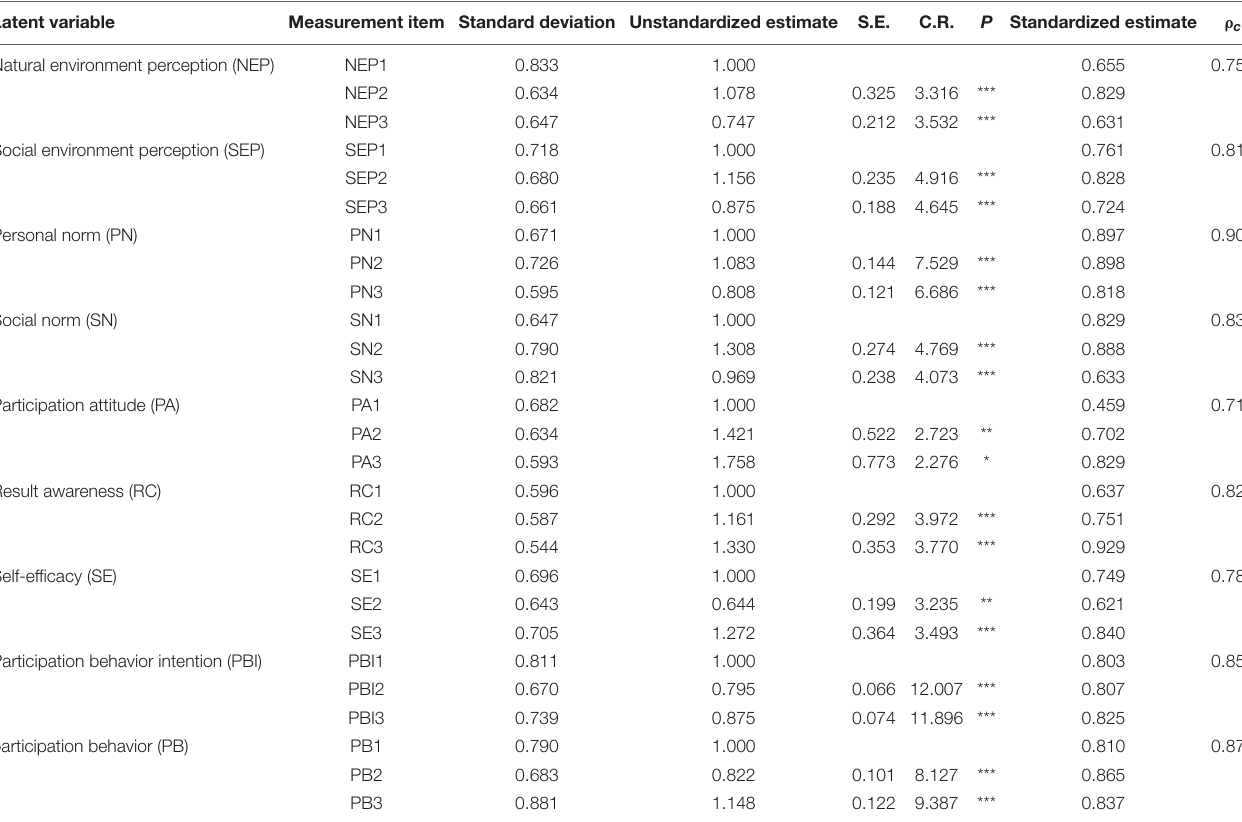
TABLE 4 | Analysis of the reliability and validity of the villagers’ participation behavior model. Latent variable Measurement item Standard deviation Unstandardized estimate S.E.